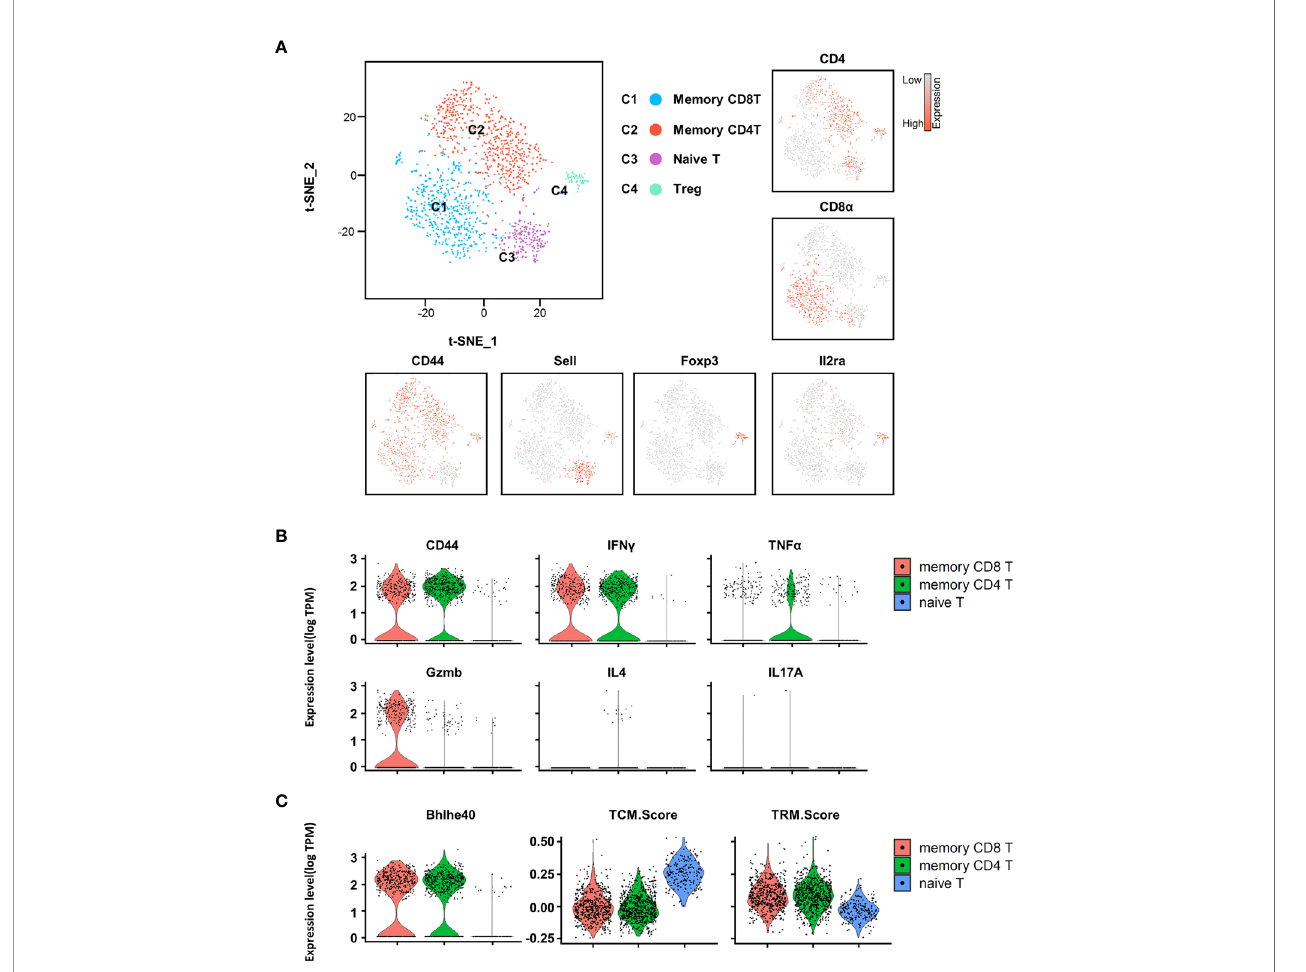
FIGURE 4 | Heterogeneity of T cells in testis revealed by scRNA-seq analysis. (A) t-distributed stochastic neighbor embedding (tSNE) and clustering analysis of combined single-cell transcriptome data of testicular immune cells from C57BL/6 mice (a single experiment with a sample containing cells pooled from 10 mice). Each dot represents a single cell and is colored according to its cluster identity as indicated on the fi gure key. The four-cluster identities were assigned based on marker gene expression. (B) The violin plots show the expression levels of CD44, IFN- g , TNF- a , Gzmb, IL4, and IL17A on memory CD8 + T cells, memory CD4 + T cells, and naïve T cells. (C) The violin plots show the expression levels of TCM (central memory) and TRM cell signatures on memory CD8 + T cells, memory CD4 + T cells, and naïve T